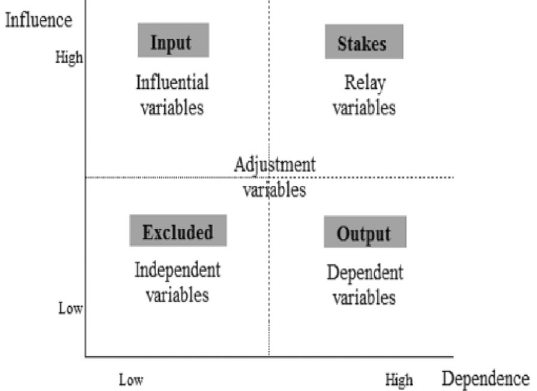
Fig. 1 Influence–dependence chart, adapted from Chen